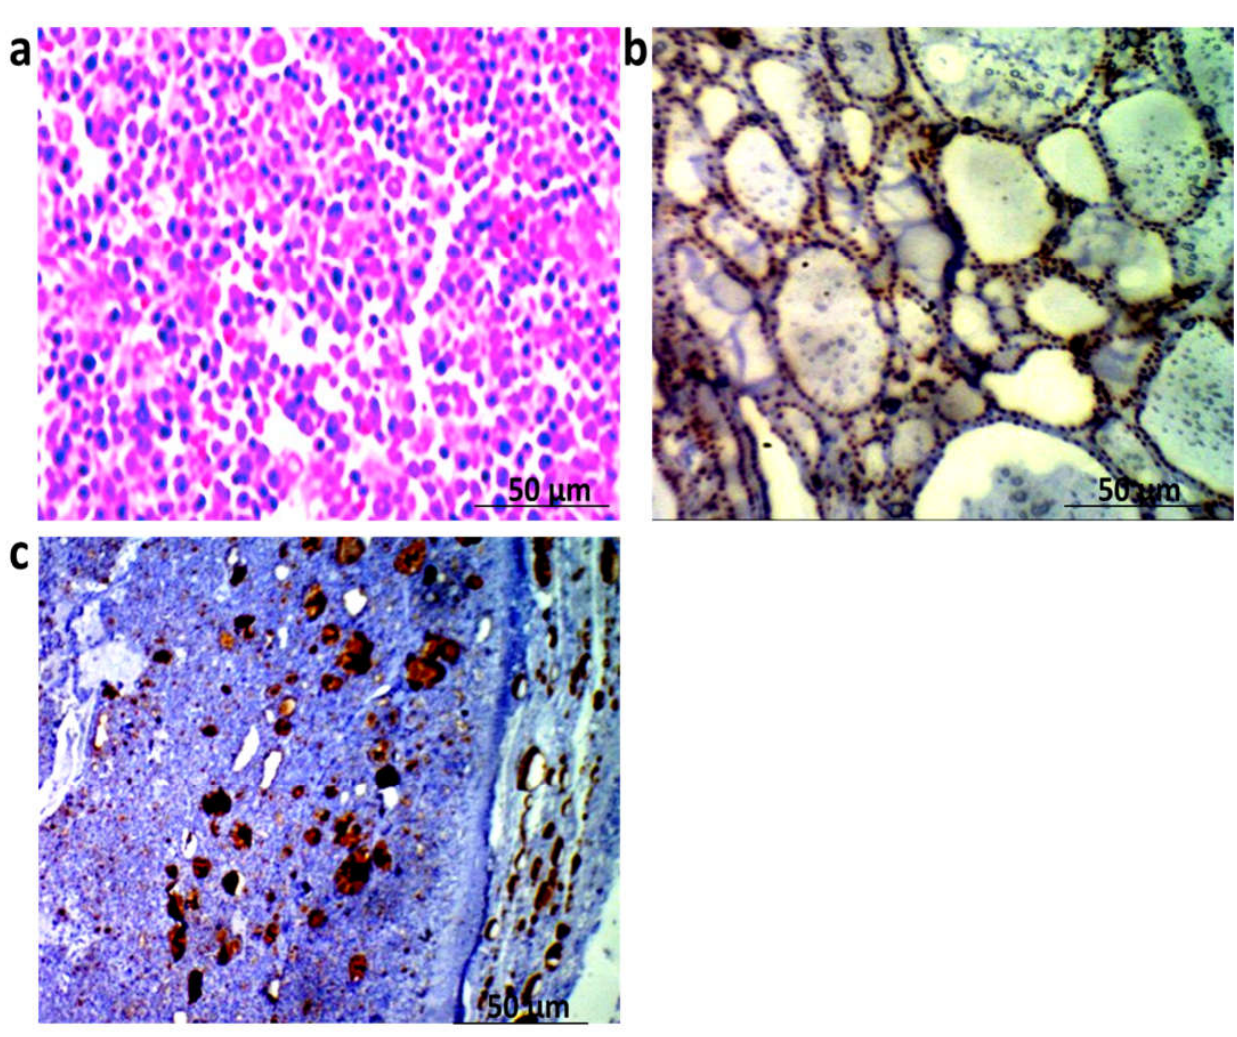
Figure 3. ( a ) Mild expression of TG in thyroid tissue of control group, TG antibody IHC, bar = 50 µm. ( b ) Thyroid gland tissue of stage I thyroid carcinoma group showing increase of TG expression